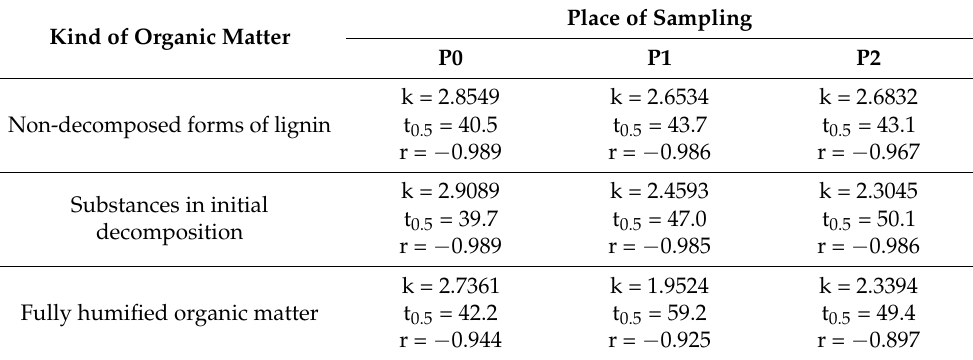
Table 5. Pseudo-first-order rate constants (k × 10 − 4 s − 1 ), half-times (t 0.5 , min), and correlation coefficients (r) for the reaction of the release of organic matter from peat